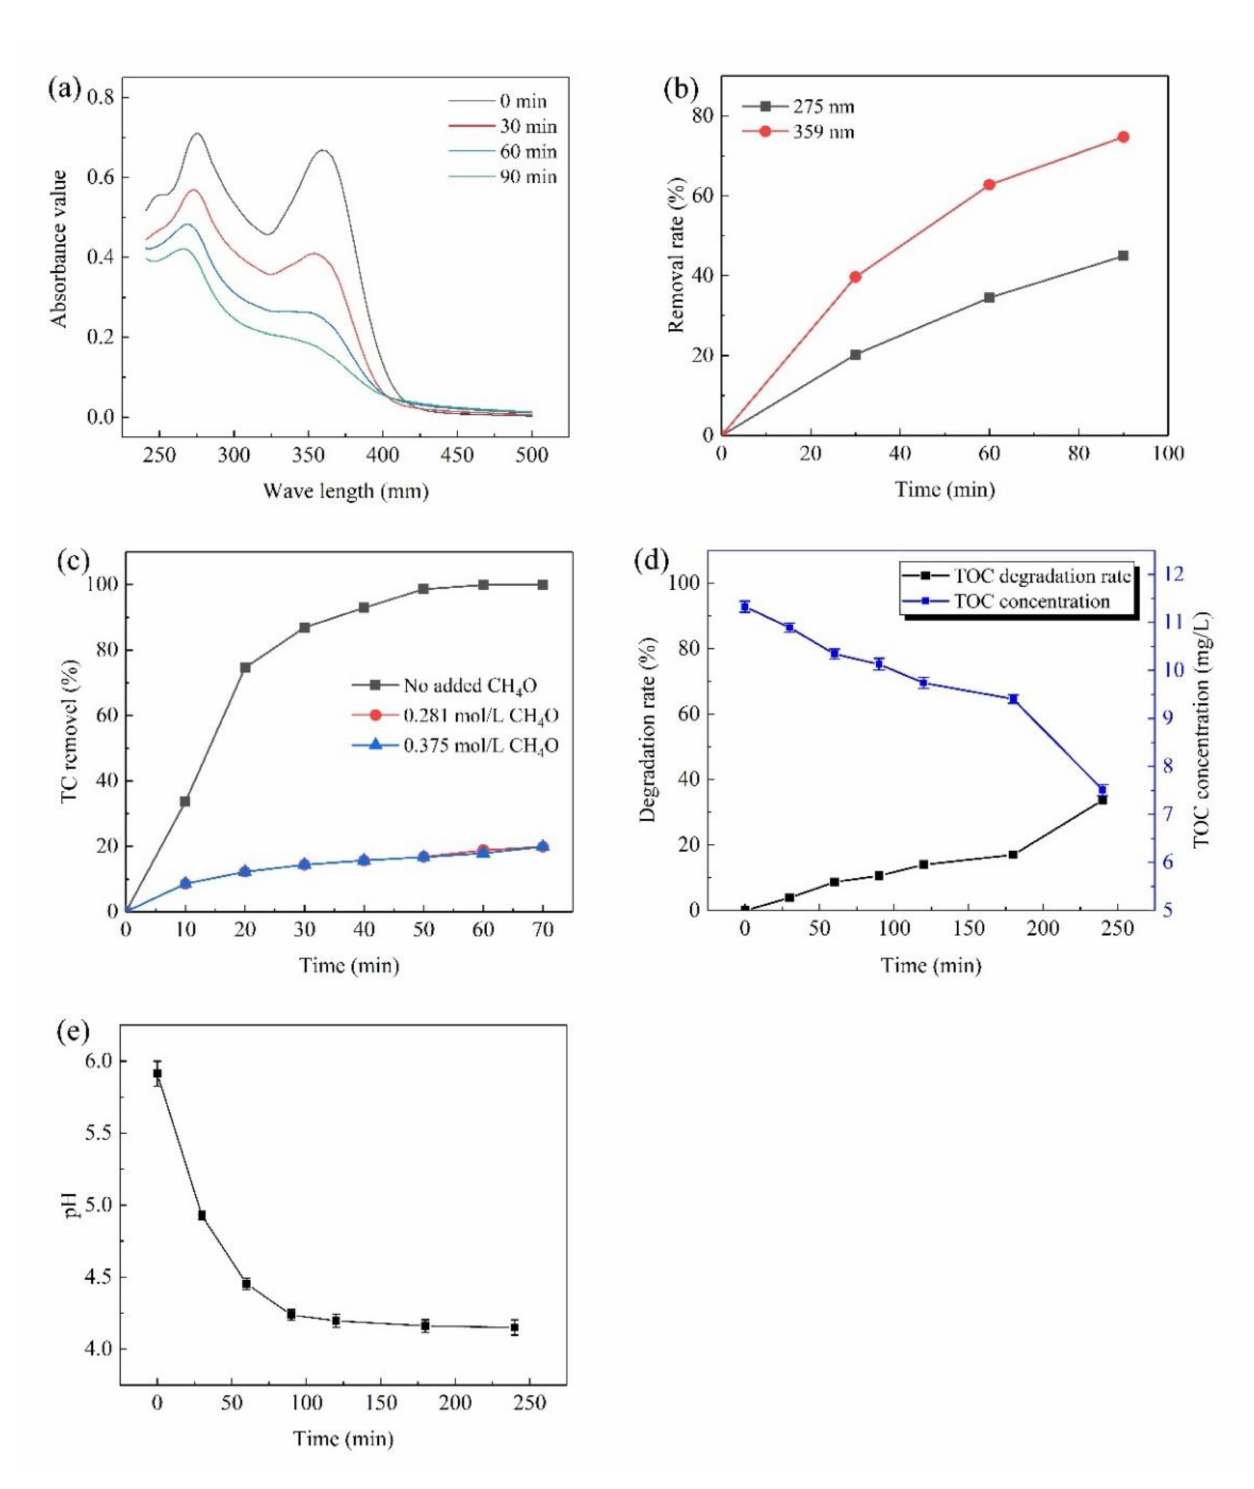
Figure 6. Changes in UV–vis absorption spectra ( a ), the relative absorbance removal at 275 nm and 359 nm ( b ), the · OH verification ( c ), the TOC ( d ) and pH ( e ) during electrochemical